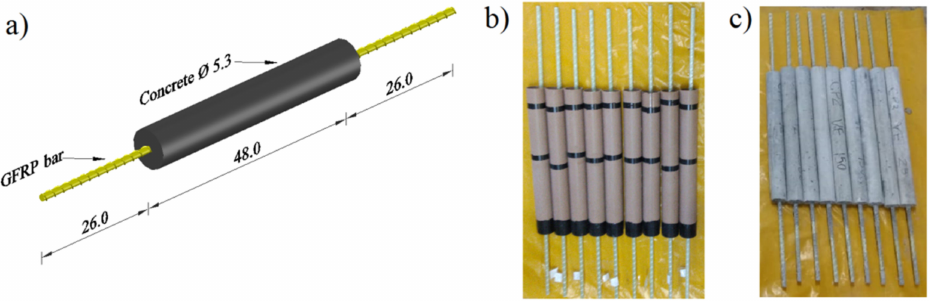
Figure 2. Samples GFRP-Y: ( a ) Dimensions (length in centimeters), ( b ) Molds in PVC tube for cylindric concrete, and ( c ) Samples GFRP-Y formed by GFRP rebar and concrete covered. The GFRP bar specimens without concrete coating (GFRP-N) and with the concrete coating (GFRP-Y) were prepared for the tensile